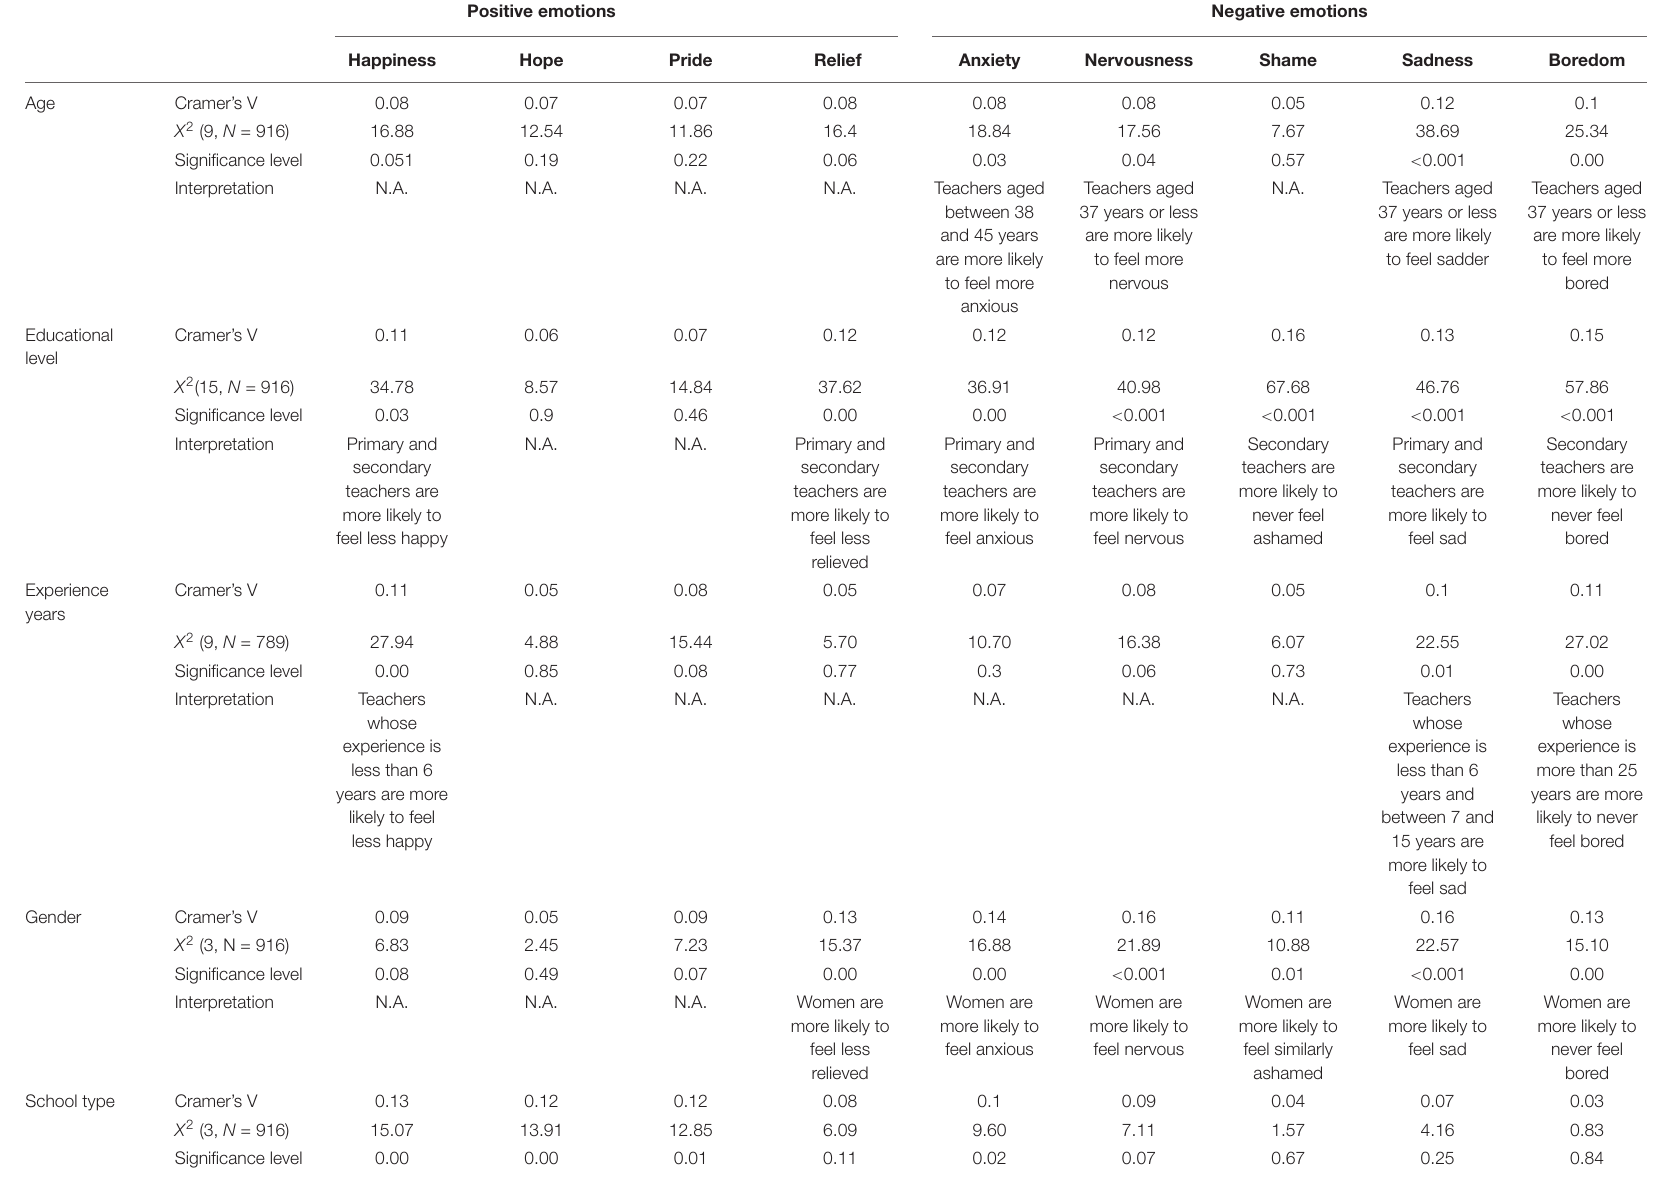
TABLE 5 | Teachers’ positive and negative emotions during emergency remote